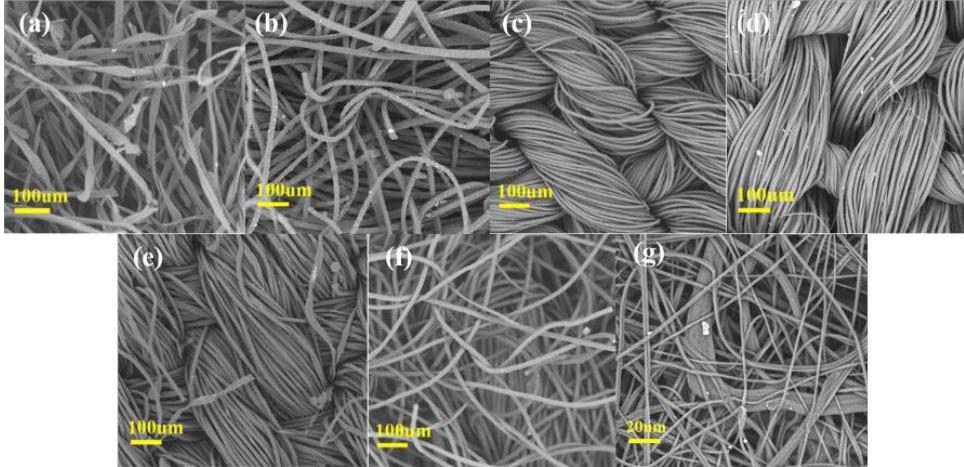
Figure 3. SEM images of ( a ) Cotton 3, ( b ) Wool 1, ( c ) Polyester 2, ( d ) Silk 1, ( e ) Blend 1, ( f ) Blend 2, and ( g ) Melt-blown fabrics.